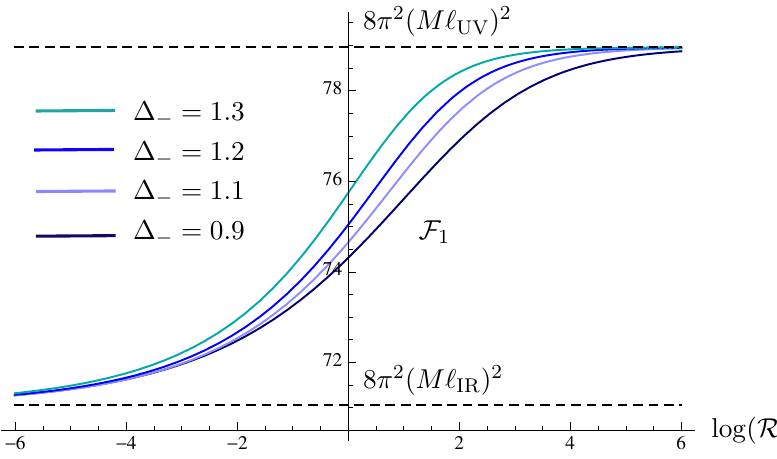
Figure 8. F 1 vs. log( R ) for a holographic model with dilaton potential (4.31) and (cid:1) (cid:0) = 0 : 9 (dark blue), 1 : 1, (light blue), 1 : 2 (blue) and 1 : 3